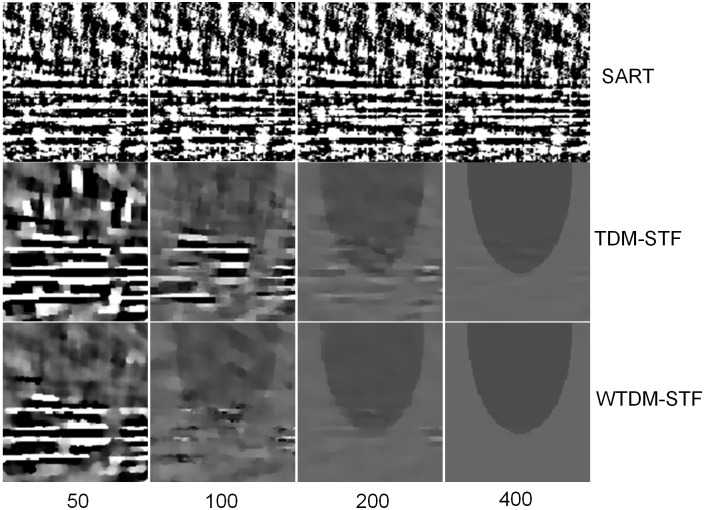
Zoom-in views of images reconstructed by SART (first row), TDM-STF (second row) and WTDM-STF (third row) algorithms after 50, 100, 200, 400 iterations, respectively.The gray scale window is set to [1.03, 1.08].